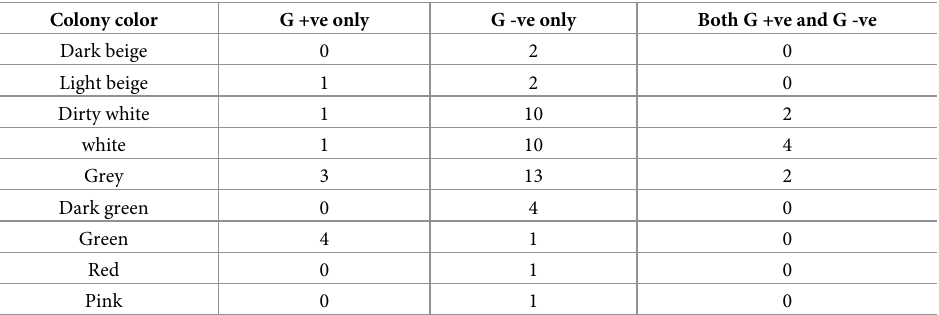
Table 1. Number of bioactive actinomycetes isolates with inhibitory activity against pathogenic bacteria. Colony color G +ve only G -ve